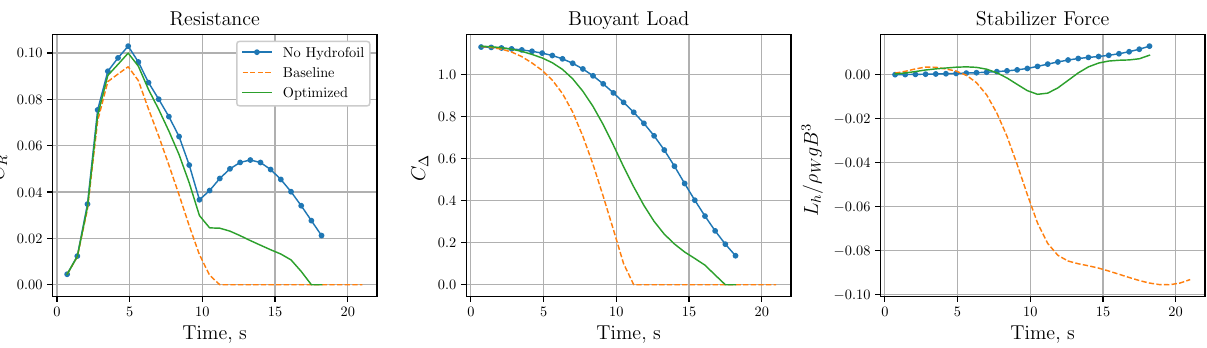
Figure 19. Force comparisons of the amphibious aircraft with and without the hydrofoil, considering both the baseline and optimized hydrofoil